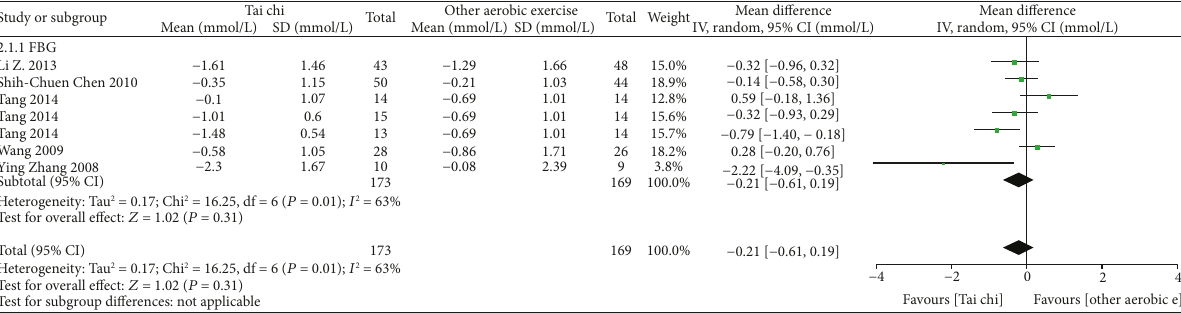
Figure 3: The meta-analysis for comparing FBG between Tai chi and other aerobic exercises. CI: con fi dence interval; SD: standard deviation. Study or subgroup